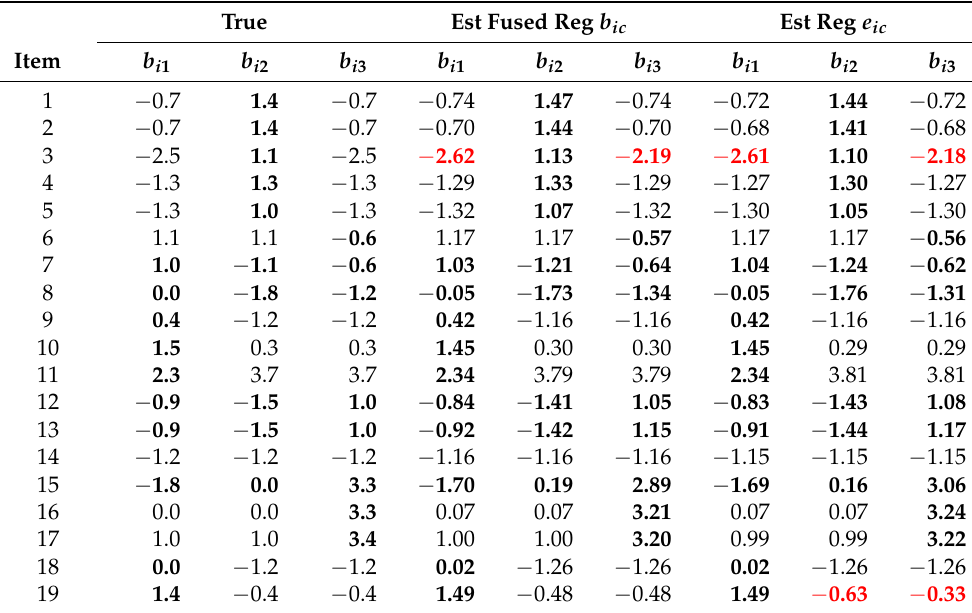
Table 5. Simulated Case Study 3: True and estimated item